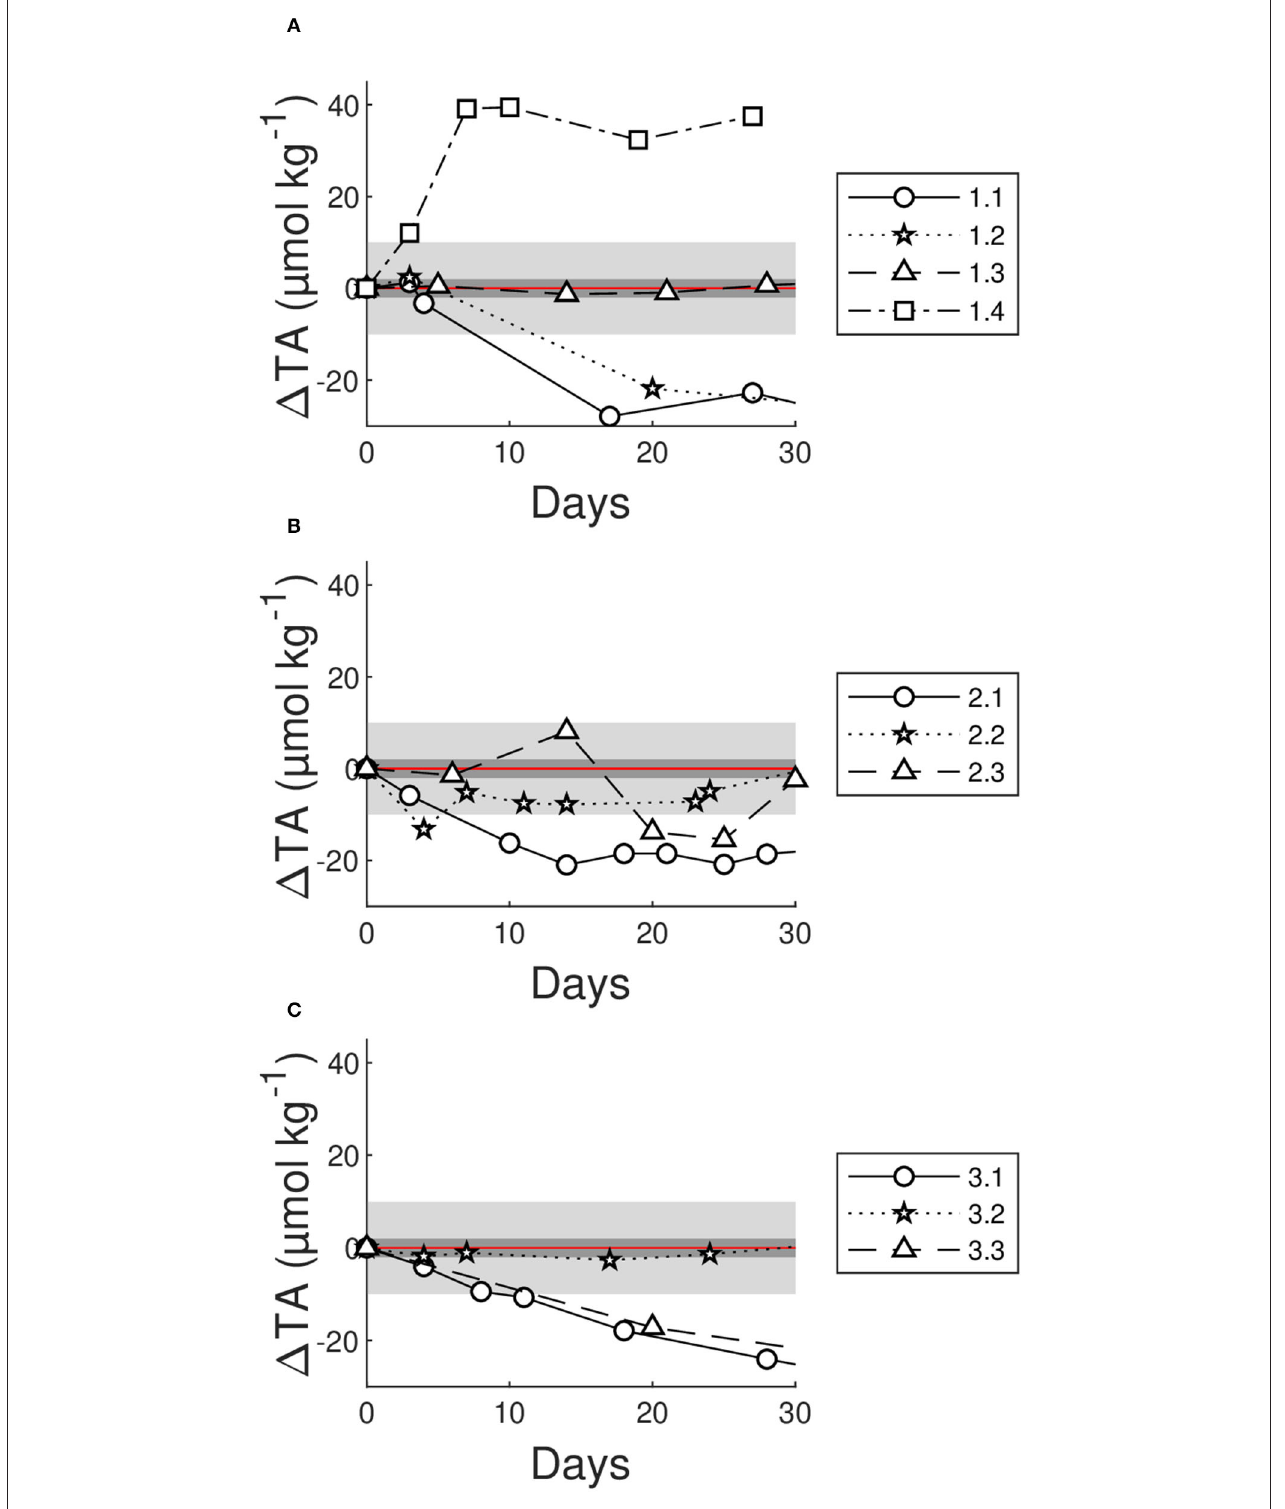
FIGURE 5 | Difference between measured TA after x days and TA start ( 1 TA x ) for each container type as a function of the measurement day x , where (A) shows the gas sampling bags, (B) the infusion bags, and (C) other container types. The numbers in the legend represent each tested container following the numbering in Table 1 . The horizontal red line in each plot represents 1 TA x = 0 µ molkg − 1 . The light gray and the dark gray areas indicate the ICOS required uncertainty of ± 10 µ molkg − 1 , and the analyzers typical relative field uncertainty of 0.10 % (equals ± 2.2 µ molkg − 1 at TA = 2215 µ molkg − 1 ) (Seelmann et al., 2019), respectively.